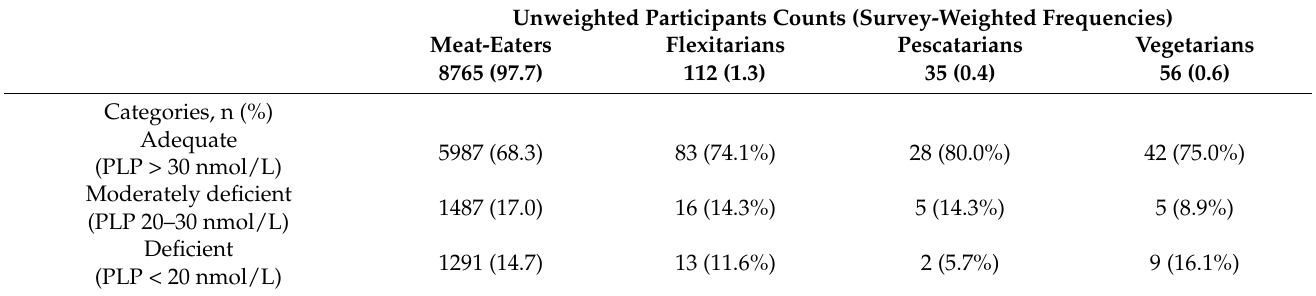
Table A4. Survey-weighted categories of vitamin B6 supply across NHANES 2007–2010 study participants following a vegetarian, pescatarian, flexitarian and meat-eating diet based on PLP a serum concentrations (n =